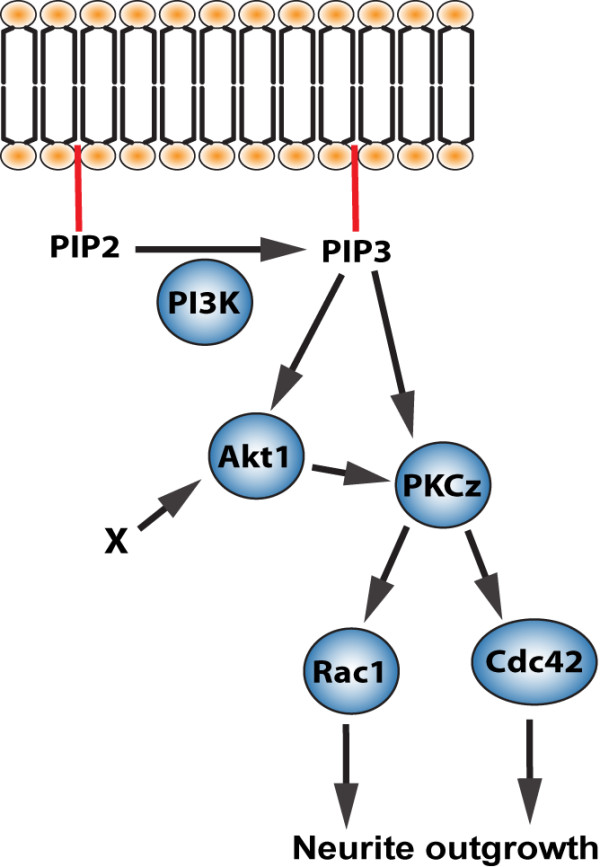
Proposed model of neurite outgrowth pathway in postnatal SVZ/RMS-derived neurons. The PI3K catalyzes phosphorylation of PIP4,5 (PIP2) to produce PIP3,4,5 (PIP3), which in turn activates Akt1 and PKCζ. It is likely that Cdc42 is preferentially activated directly via PIP3 to PKCζ and for Rac1 preferential activation is via PIP3,4,5 and Akt1 to PKCζ. Akt1 can be also activated by other kinases.